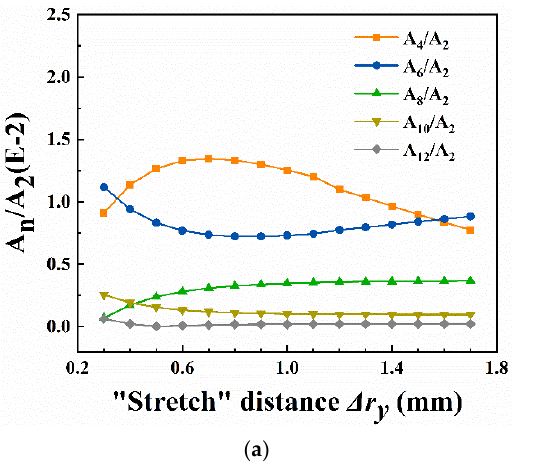
Figure 6. Variation of the high-order fields with Δ r y at r x = 1.4 mm. ( a ) 2-slit model; ( b ) 4-slit model. More slits on electrodes introduced higher-order fields and increased the overall contents.